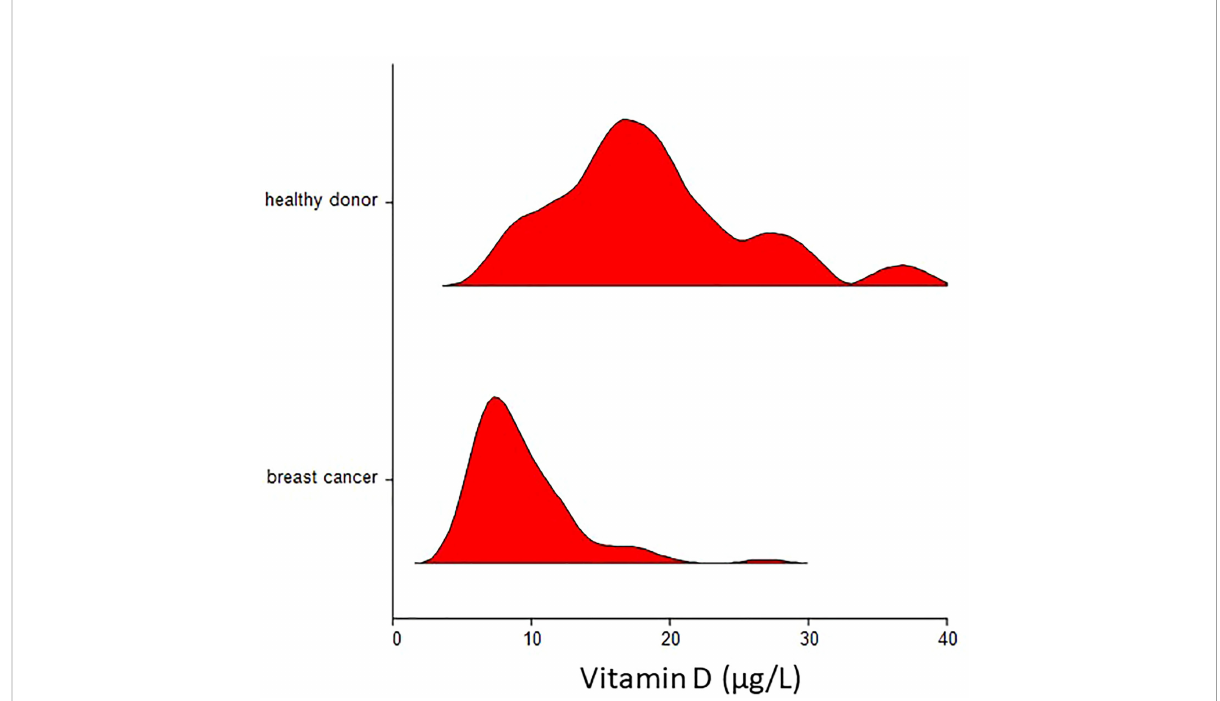
FIGURE 1 Violin plot of plasma vitamin D concentration in breast cancer patients and healthy donors. Mean ( ± SD) vitamin D plasma level was 9.3 ± 3.65 µg/L for breast cancer patients as compared to 18.6 ± 6.8 for healthy donors (p <